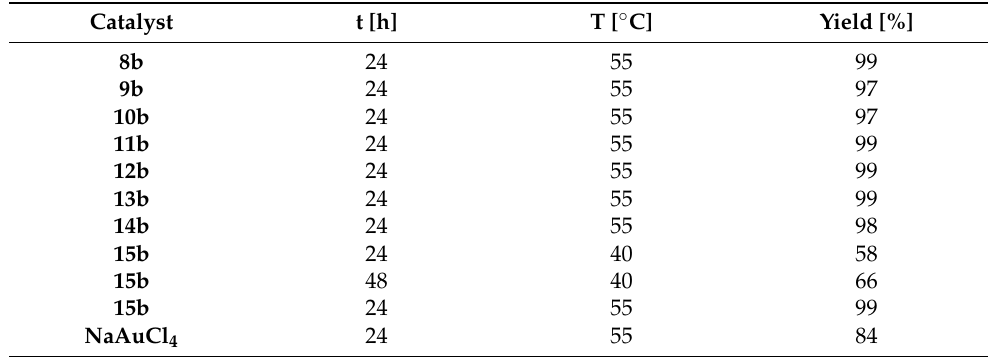
Table 1. Yields of three-component reaction between phenylacetylene, benzaldehyde and piperidine catalyzed by tetrachloroaurate(III) salts 8b –